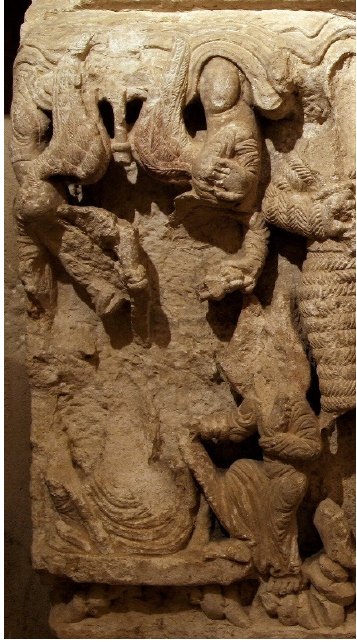
Figure 4. Almazán. Frontal (detail). Resurrection . Figure 4. Almaz á n. Frontal (detail). Along the bottom of the slab, a pattern of large fleshy leaves curling at the edges and containing pinecones, in a very similar design to the decoration of the cymatia and im- posts on the vault capitals, forms the base on which the different scenes stand.